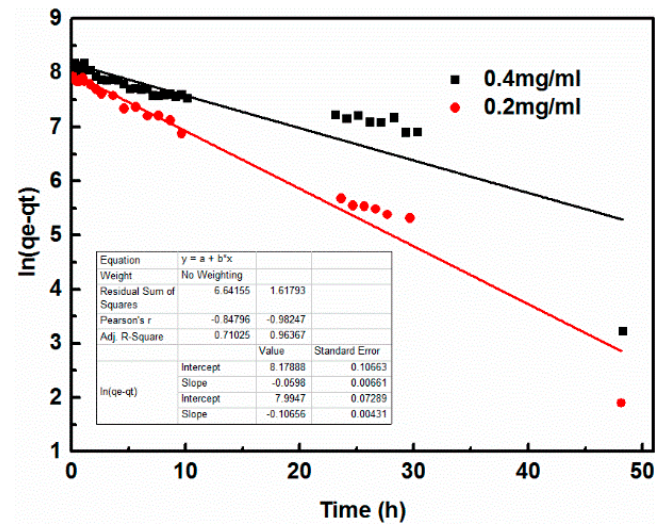
Figure 4. Pseudo first-order kinetics with different GO concentrations.